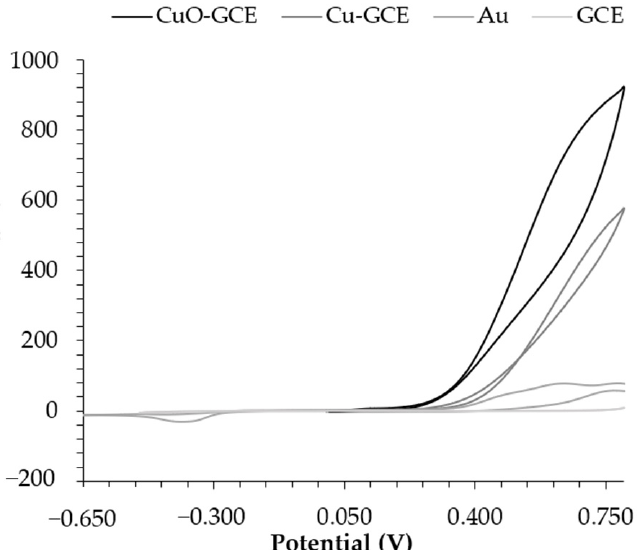
Figure 6. Cyclic voltammetry (1 cycle, − 0.00 to 0.85 V vs. Ag/AgCl) with 5 mM glucose in 0.1 M NaOH with copper, copper oxide gold, and glassy carbon electrode.